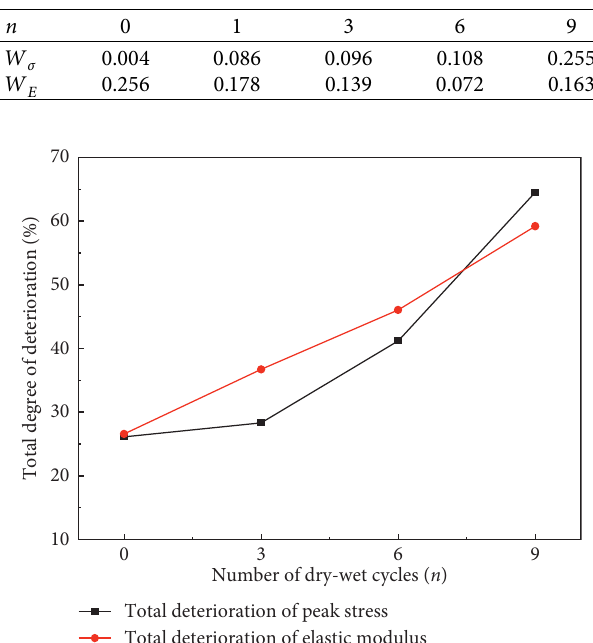
Figure 8: The n - S i curve for each group of parameters.